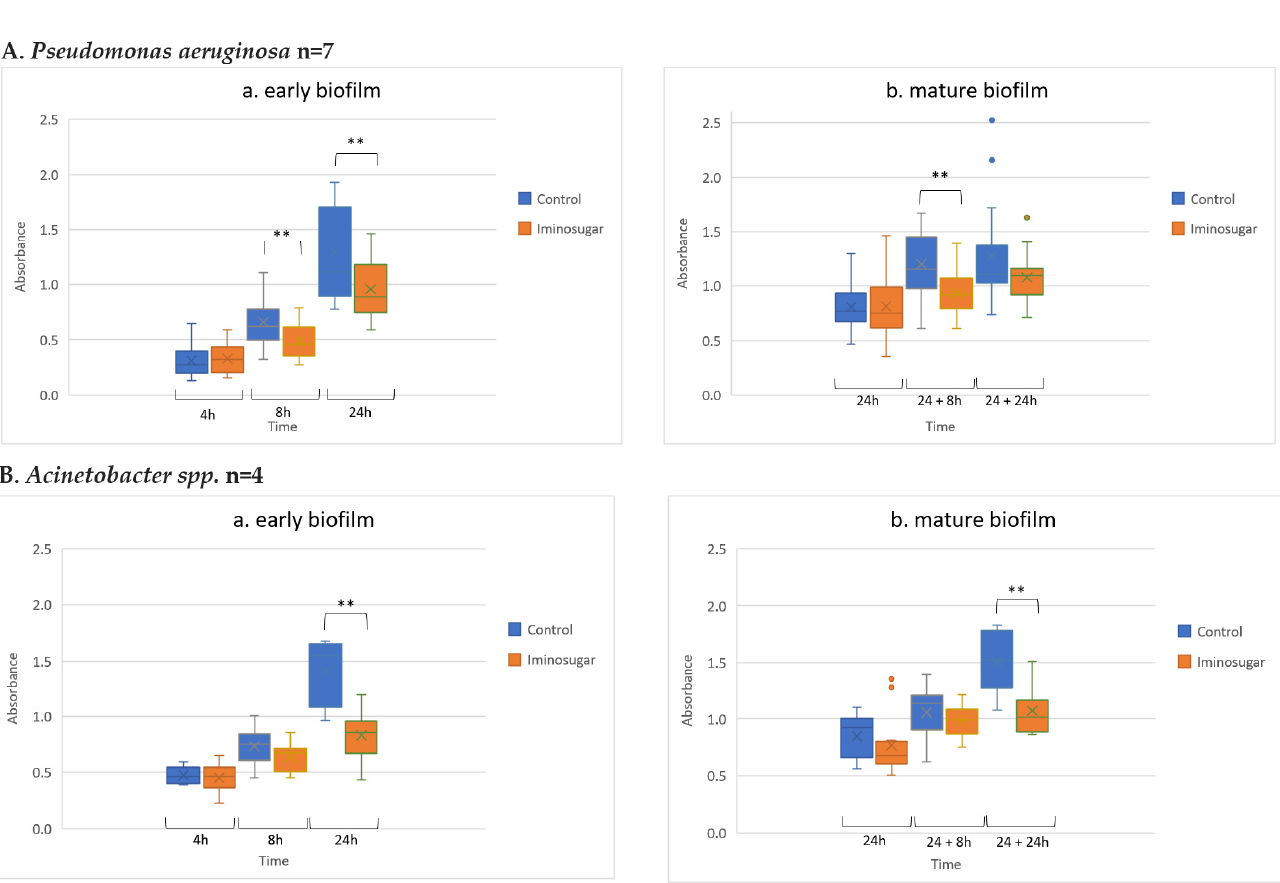
Figure 2. Effect of iminosugar PDIA on biofilm production by selected Gram-negative Enterobacteriaceae . ( A ), Klebsiella spp., ( B ), and Enterobacter spp. in ( a ) early biofilm and ( b ) mature biofilm. n refers to the number of strains. The figure represents biofilm absorbance readings for all strains belonging to a given species at a given time (measurements for each strain were performed in triplicates). Biofilm production expressed as absorbance ( λ = 492 nm) after Congo red staining at different time points. * p < 0.05 and ** p < 0.01.